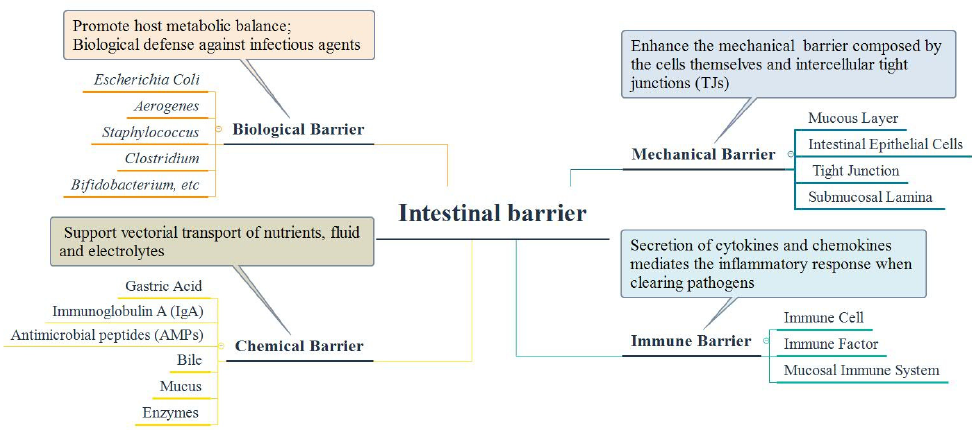
Figure 3. Composition and functions of the intestinal